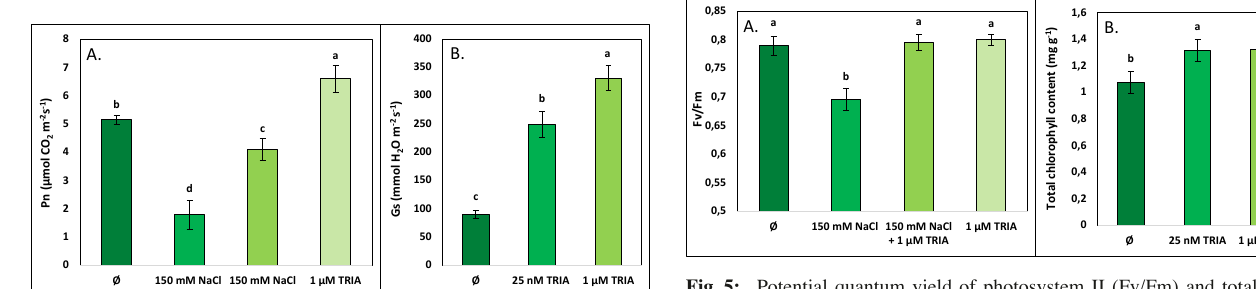
Fig. 5: Potential quantum yield of photosystem II (Fv/Fm) and total chlo- rophyll content in leaves of spinach plants exposed to high salinity, with or without triacontanol (TRIA) treatment. Ø stands for the con- trol group. Vertical bars represent ± standard error from means (n=5), different letters above the columns indicate significant differences at P < 0.05 (Tukey’s HSD